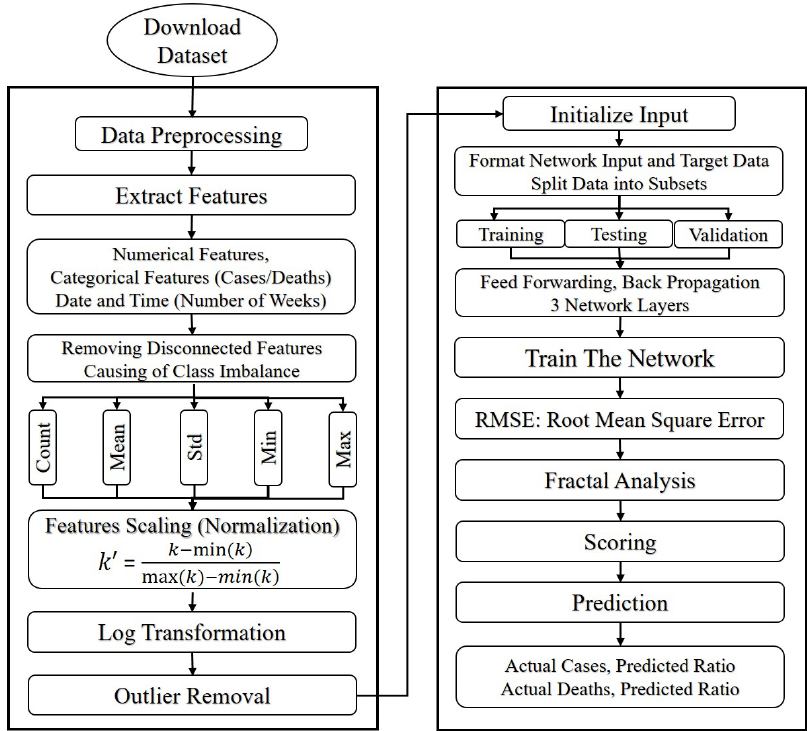
Figure 1. Flowchart diagram of our proposed model.